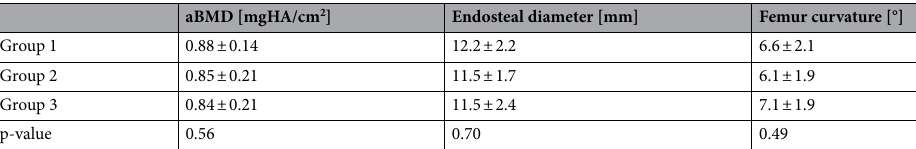
Table 1. Bone architecture parameters in the three study groups, presented in terms of mean value and standard deviation, and p-values from the corresponding comparisons among the groups.